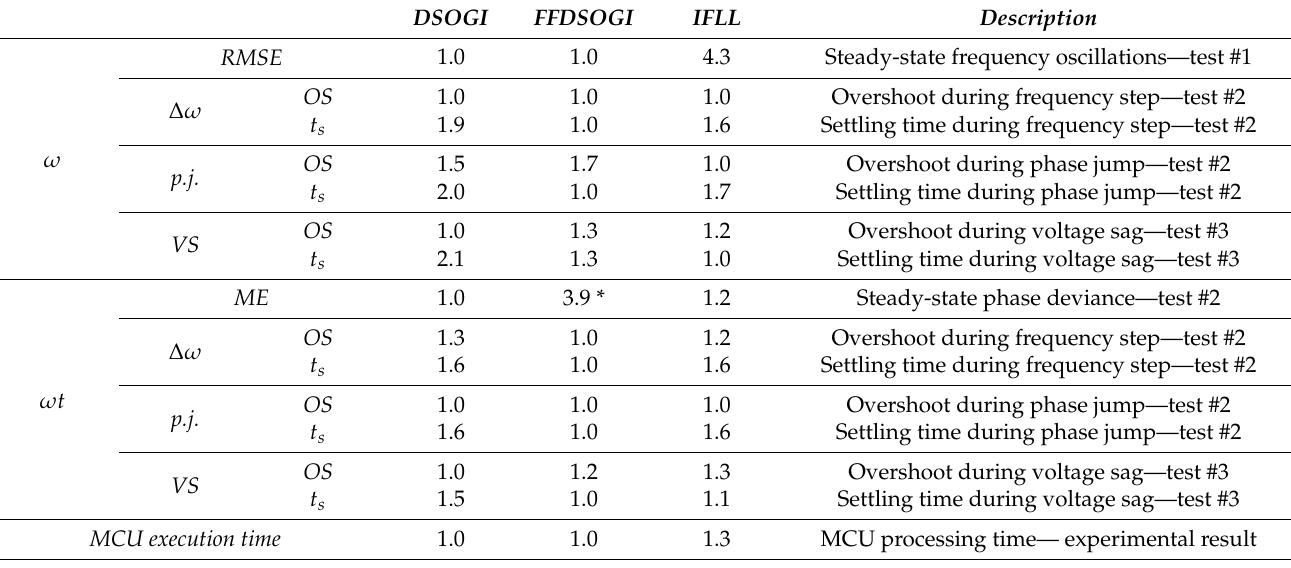
Table 12. Classification table of the methods’ performance during different